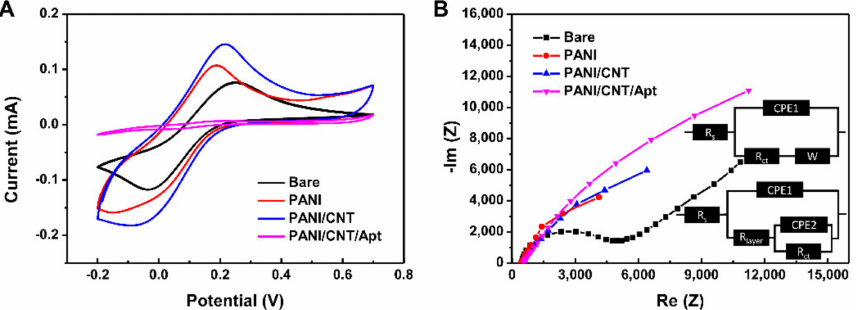
Figure 5. ( A ) Cyclic voltammetry (CV) at scan rate of 50 mV/sec and ( B ) the electrochemical impedance spectroscopy (EIS) at 0.2 V (vs. Ag/AgCl) in the frequency range of 100 kHz to 10 MHz spectra in 10 mM (Fe(CN) 6 ) 3 − /4 − as the redox PBS buffer solution measured on PANI, PANI/CNT, and PANI/CNT/Apt-modified electrodes and unmodified SPCE. The inset is the electric circuit compatible with the Nyquist diagrams for the modified electrodes. R s : Electrolyte resistance; R ct : Charge transfer resistance; CPE1: Constant phase element; and W: Warburg diffusion